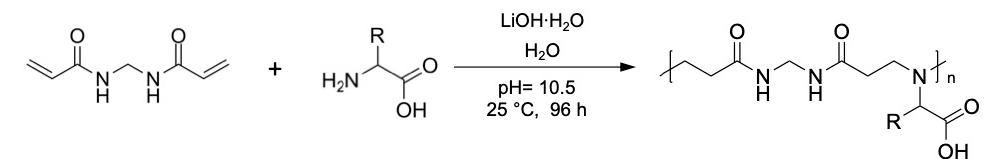
Table 2. Structure of the α -amino acid-derived PAA repeat